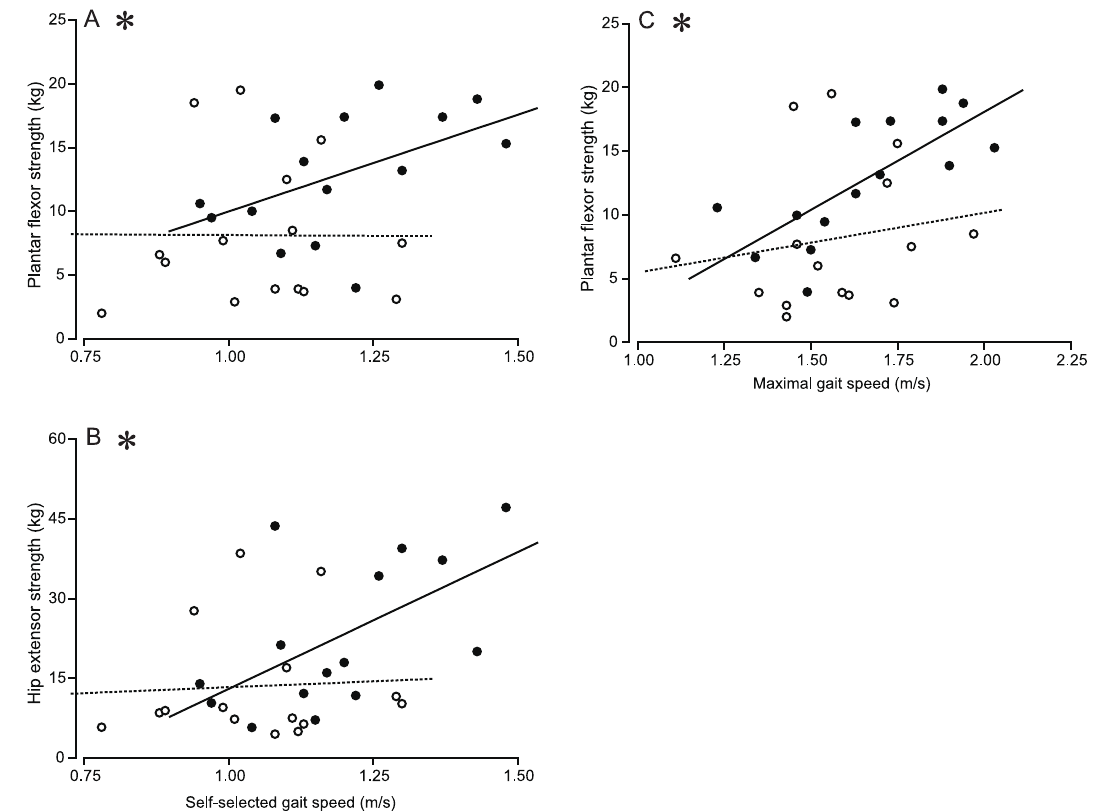
Figure 1. Linear regression of self-selected and maximal gait speed on leg strength before (open symbols, dashed regression lines) and after 16 sessions of leg press training (n=15). Panel A: before, y=8.38–0.24x, after, y=8.84 + 15.16x; Panel B: before y=8.89 + 4.44x, after, y= 2 35.80 + 49.91x; Panel C: before, y=0.84 + 4.66x, after, y= 2 12.92 + 15.50x. The * denotes a significant (p , 0.05) difference in the slopes of the regression coefficient before and after training determined by small sample t-test.